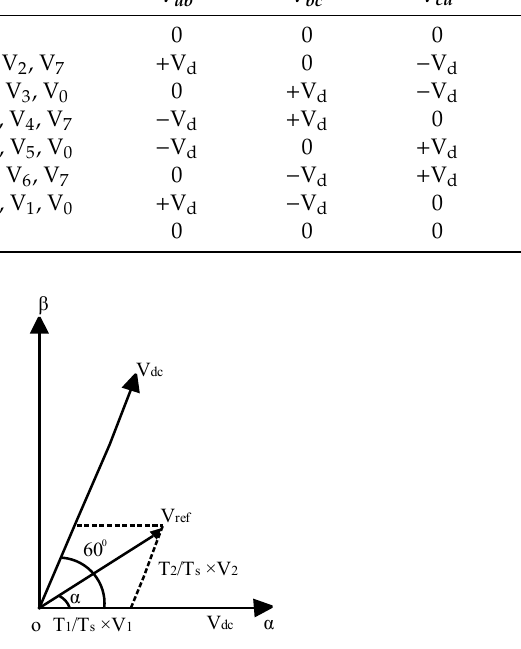
Table 2. Space vectors state and the switching sequence. Figure 4. Vector representation of the SVPWM signal .